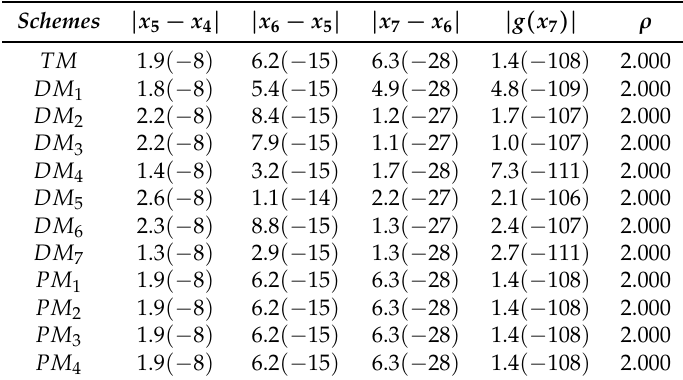
Table 2. Numerical results of Example 1.